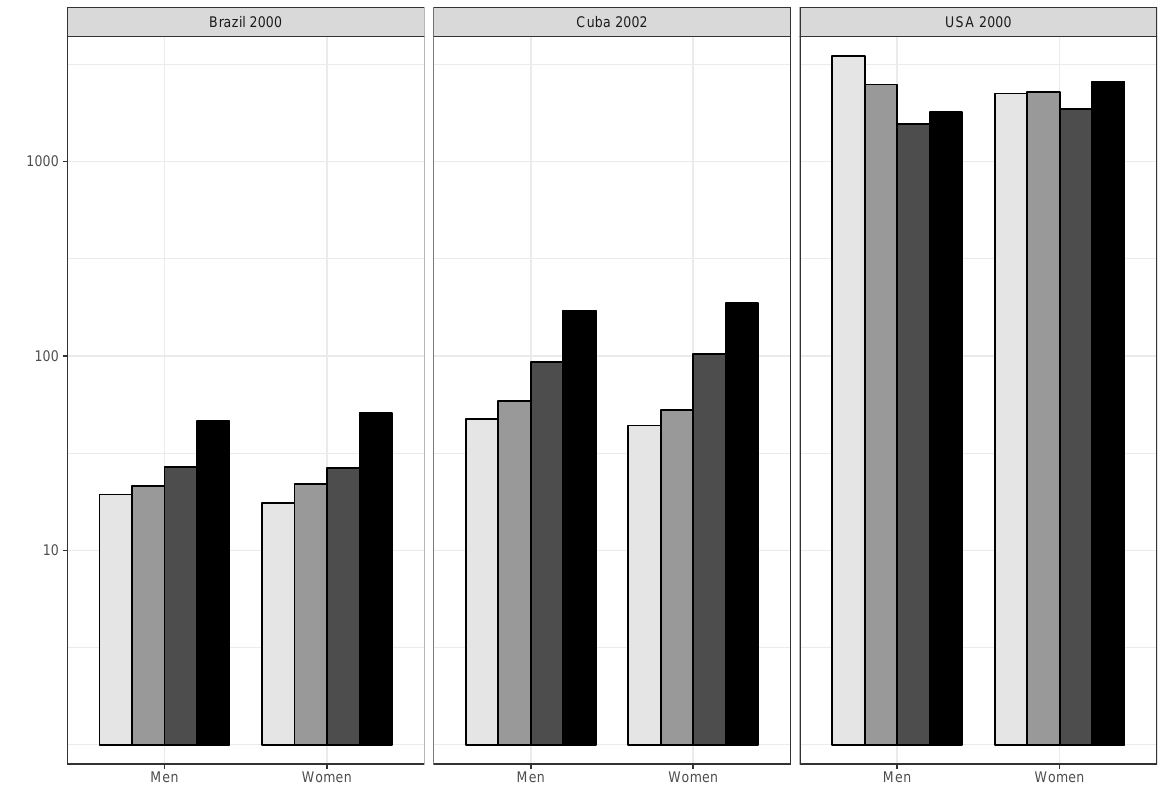
Figure 2: Estimated odds ratios for endogamy levels between whites and blacks by educational attainment among married and cohabiting unions of women aged 25 to 34 in Brazil 2000, Cuba 2002, and the United States 2000 (model 5). Source : Own calculations based on census microdata,